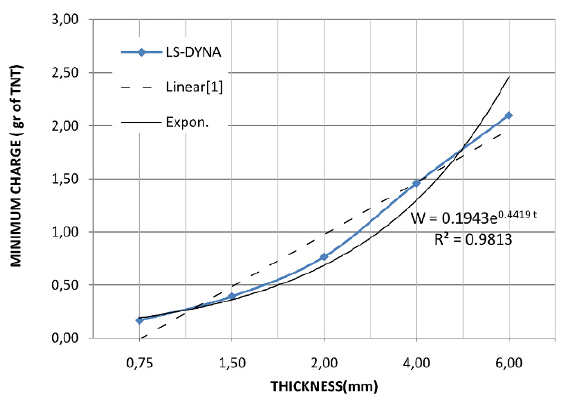
Figure 13. Comparison between the minimum simulated and experi- mental charges for 200 mm diameter.